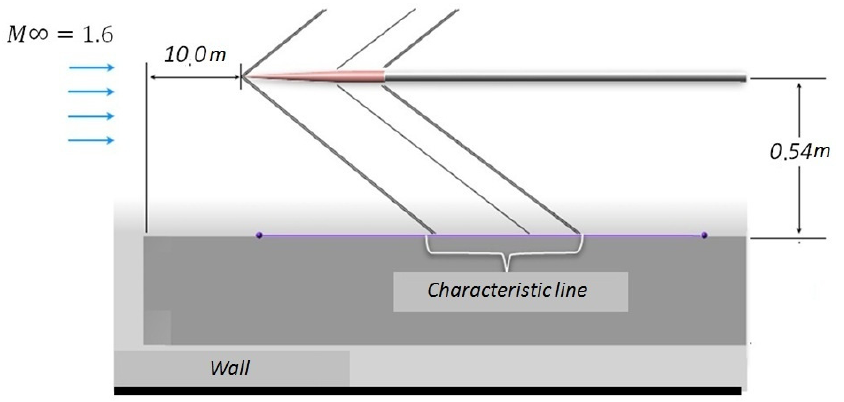
Figure 9. The experiment